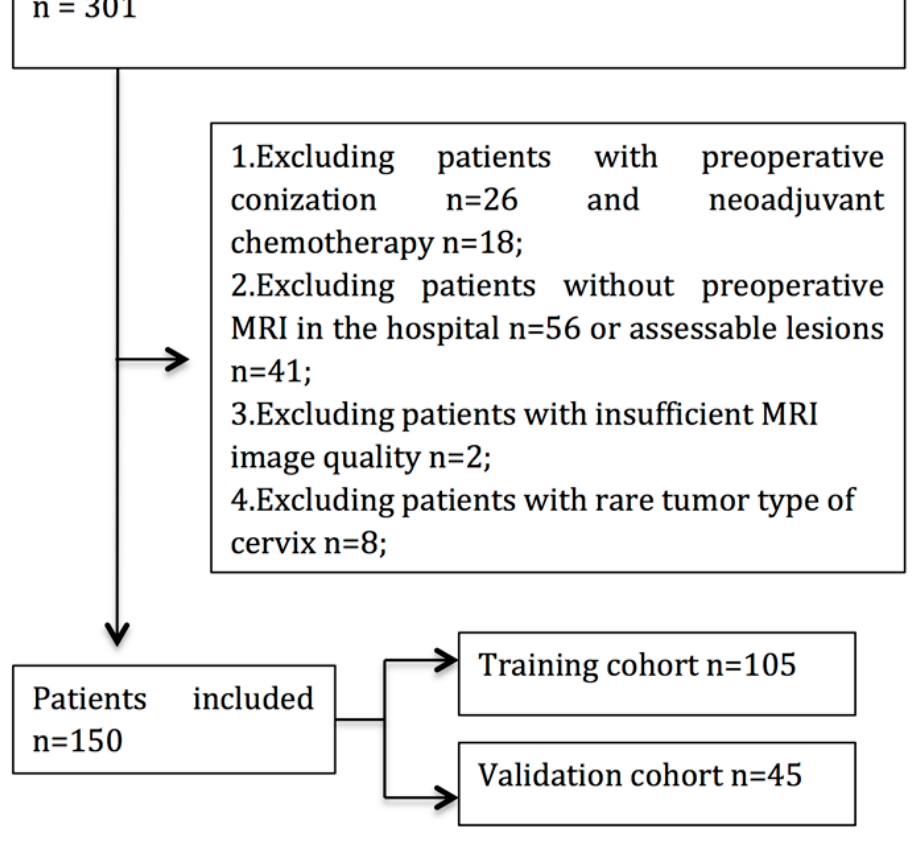
Figure 1. Flow chart of patient enrollment in this study.